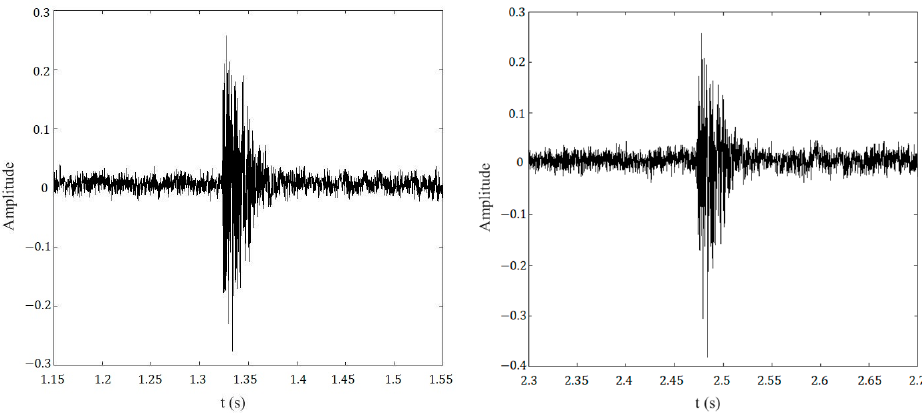
Figure 6. Typical wire break acoustic signal waveforms.